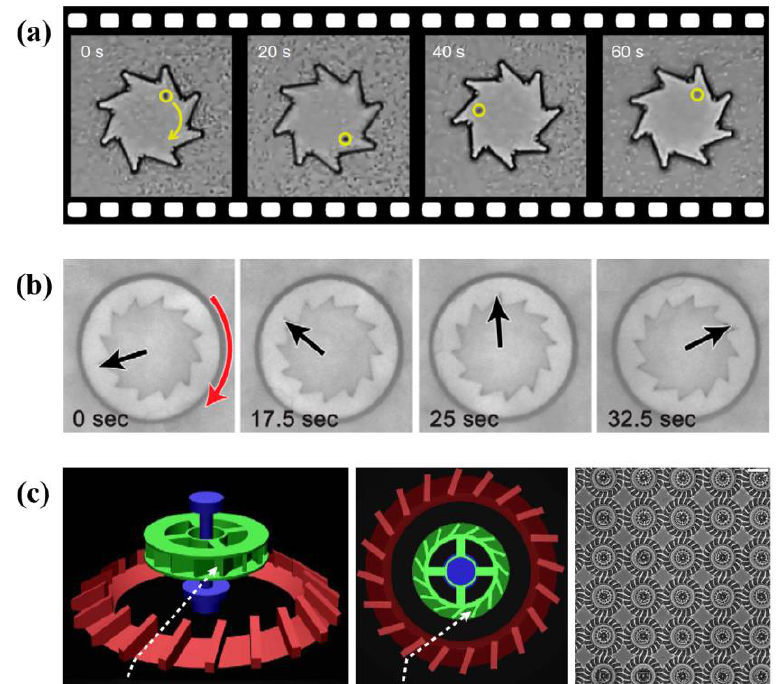
Figure 4. Several types of bacterium-driven directed NMMs. ( a ) Spontaneous rotation of micro-gears in E. coli bath. Reprinted with permission from Reference [50] , Copyright 2010, National Academy of Sciences. ( b ) Spontaneous rotation of micro-gears with internal teeth in Bacillus subtilis bath. Reprinted with permission from Reference [51] , Copyright 2010, National Academy of Sciences. ( c )